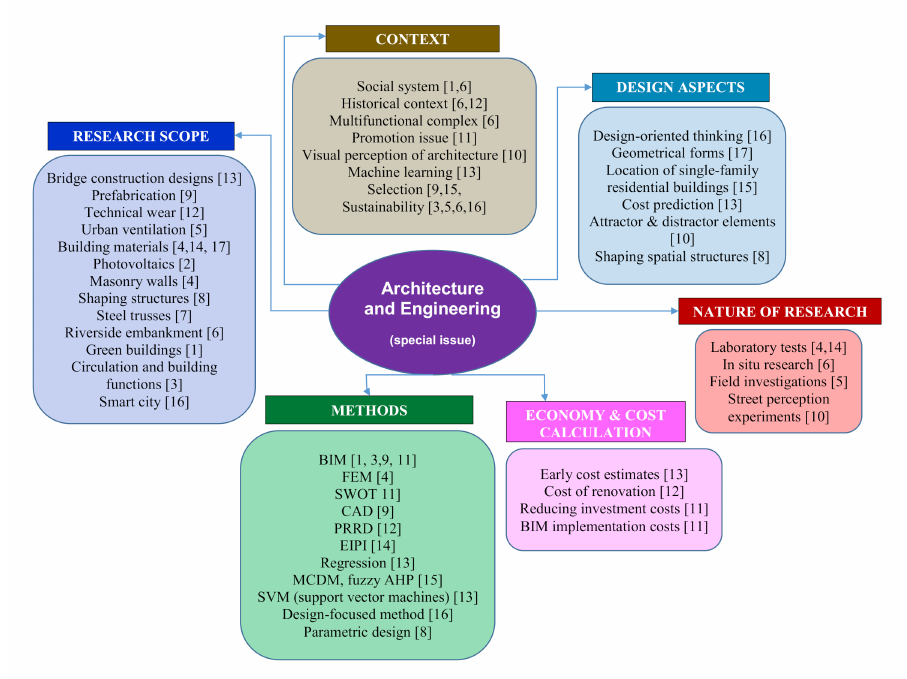
Figure 1. Research areas of case studies and their